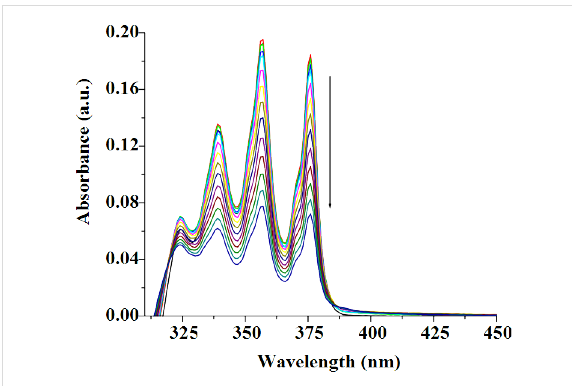
Figure 11: Absorption spectra of anthracene ( c = 2.39 × 10 − 5 M) upon gradual addition of Cu 2+ ion ( c = 1.20 × 10 − 3 M) in CH 3 CN containing 0.1%